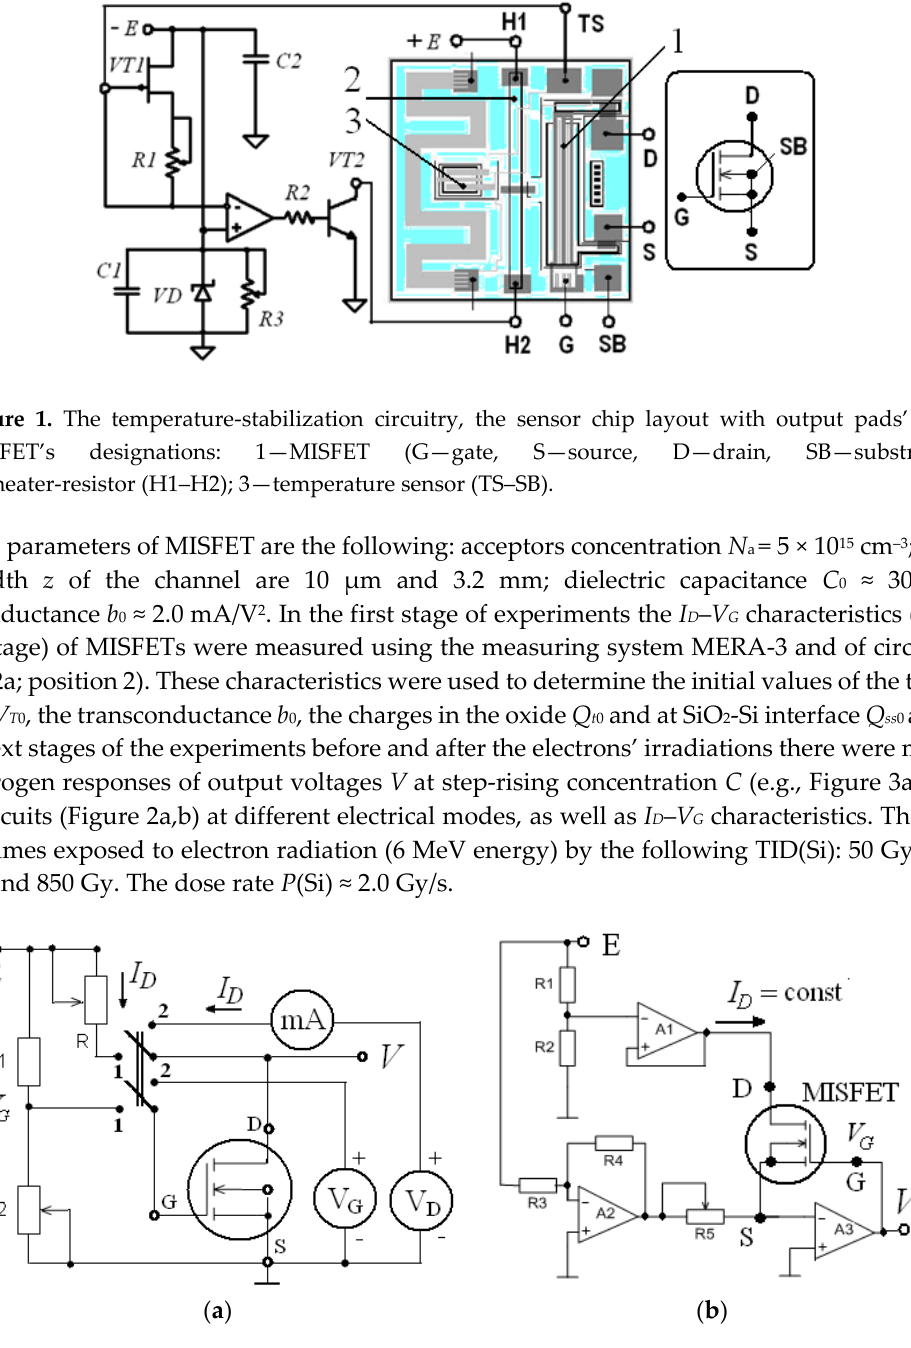
Figure 2. ( a ) The circuit No. 1 for measurement the MISFET-based sensors’ conversion functions V ( C ; D ) (position 1) and ( I D –V G ) characteristics (position 2); ( b ) The circuit No.